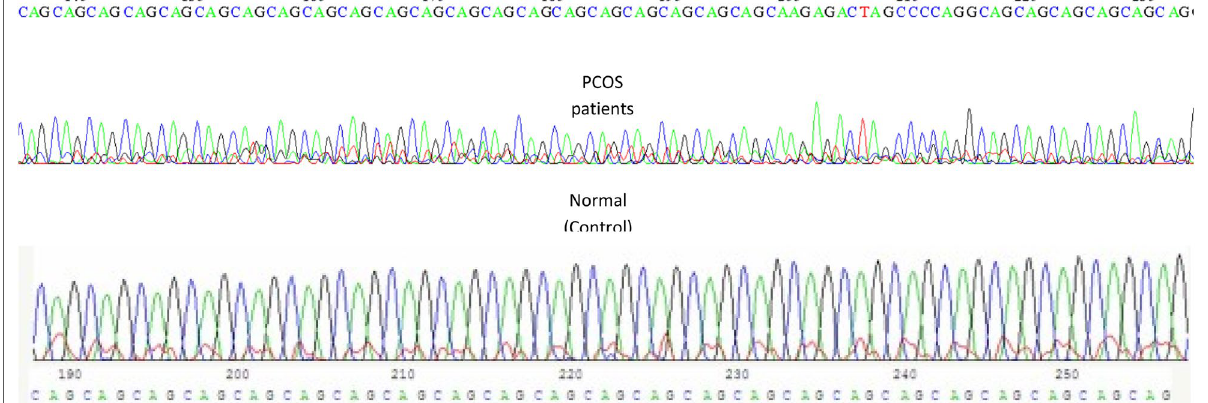
Table 5 Codon usage in PCOS patients and control